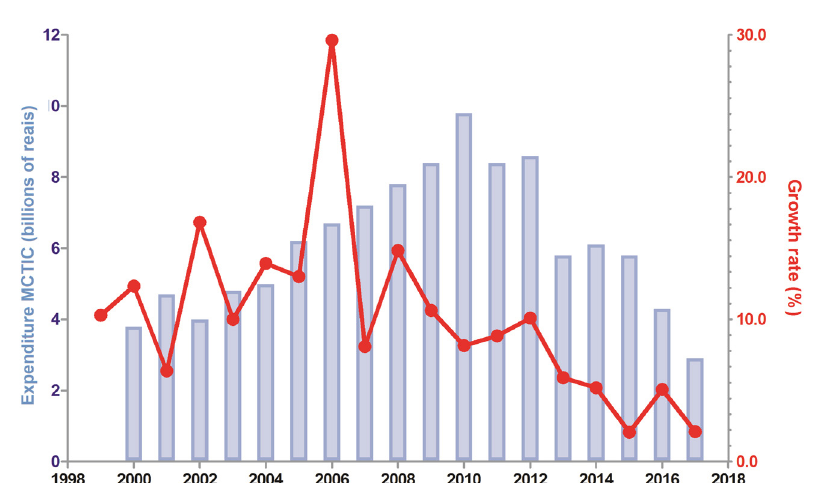
Figure 1. Annual growth rate of scientific papers output as compared with annual expenditure by Brazilian Ministry of Science, Technology, Innovations and Communications (MCTIC) (in billions of reais) from 2000 to